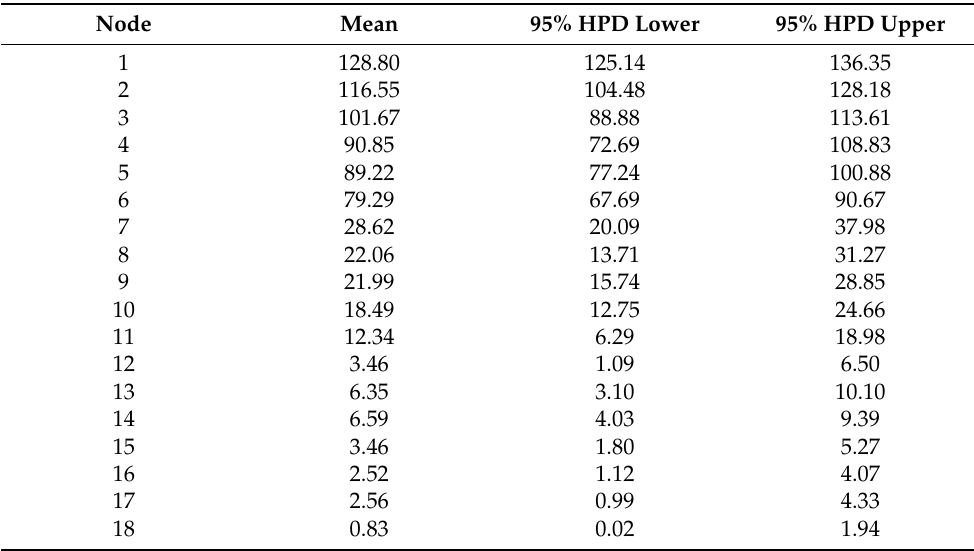
Table 3. Divergence times of relevant nodes within linyphiids estimated using a relaxed molecular clock method in BEAST. Node Mean 95% HPD